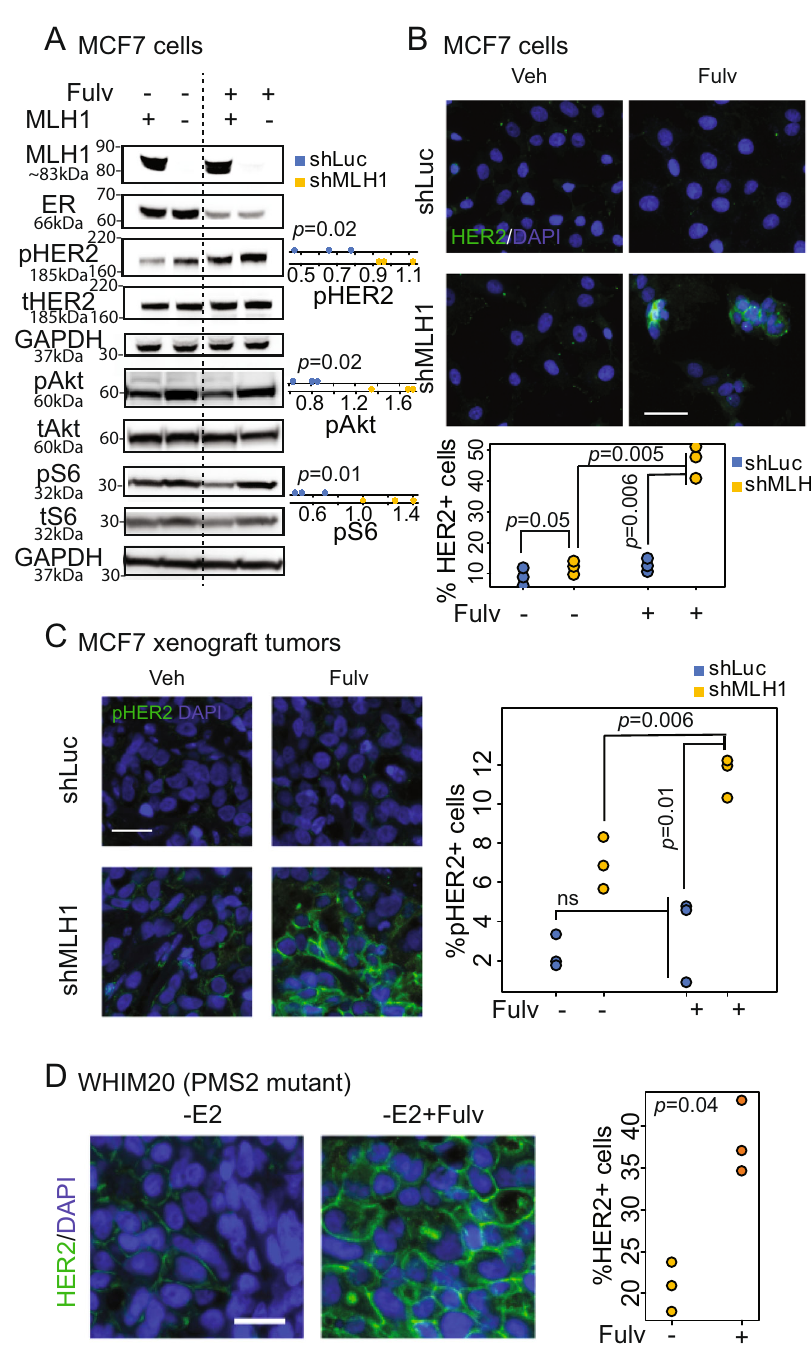
Fig. 2 MLH1 loss in ER + , nominally HER2 − breast cancer cells upregulates membrane-bound HER2. A Western blots demonstrating increase in pHER2 and downstream signaling in sh MLH1 MCF7 cells treated with fulvestrant relative to sh Luc cells. Quanti fi cation of four independent replicates conducted through ImageJ in accompanying dot plots. Validation in T47D cells in Fig. S3A. Immuno fl uorescent staining for HER2 in MCF7 sh Luc and sh MLH1 cells in vitro ( B ), in MCF7 sh Luc and sh MLH1 xenograft tumors ( C ), and in WHIM20, PMS2 mutant, ER + /HER2 − PDX tumors ( D ), grown with or without fulvestrant. Accompanying quanti fi cation presented as strip charts. Three independent experiments or tumors from each group were quanti fi ed. Two-sided Student ’ s t test determined p values. Supporting data from FACS analysis are presented in Fig. S3B, C. Scale bars represent 50 µ . Source data for all fi gures available with